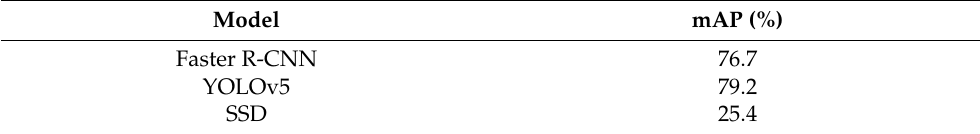
Table 4. Results of the first set of experiments.